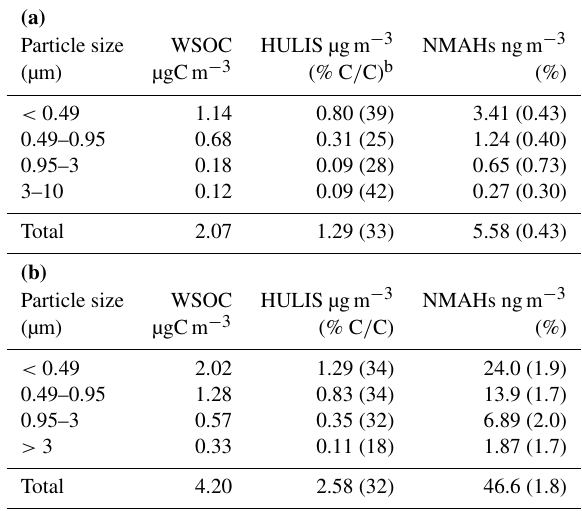
Table 3. Mean absolute concentrations and mass mixing ratios (in brackets) of HULIS a in WSOC a as well as of NMAHs in HULIS